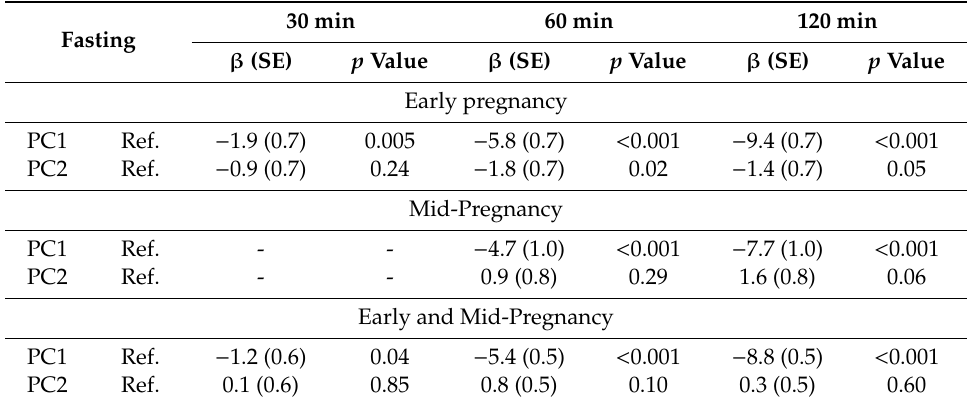
Table 3. Mean di ff erence in top principal component (PC) scores for targeted metabolites by OGTT time points at early ( n = 29), mid-pregnancy ( n = 18), and all oral glucose tolerance tests (OGTT) combined ( n = 47) 1 . 30 min 60 min 120 min Fasting β (SE) p Value β (SE) p Value β (SE) p Value − 1.9 (0.7) 0.005 − 5.8 (0.7) < 0.001 − 9.4 (0.7) < 0.001